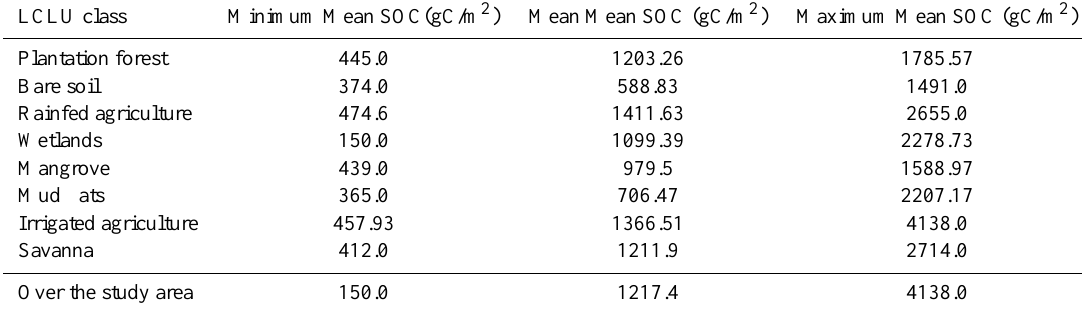
Table 6. Summary statistics of the mean of the 30 soft decision tree SOC estimates for year 2000. The statistics are summarized with respect to the 9 LCLU classes defined by the hard decision tree classification (Fig. 1). The mean study area mean SOC is 1217.4 gC/m 2 . Only pixels where SOC was modeled are considered (i.e., not water bodies, clouds, cloud shadows, settlement areas, or where there was no Landsat data).